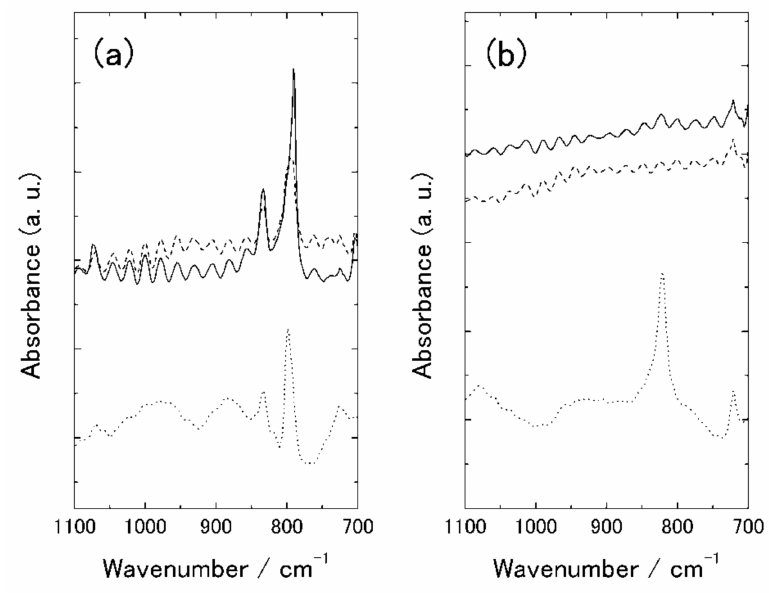
Figure 5. Polarized transmission IR spectra (upper) and IR-reflection absorption spectra (RAS) (lower) in the C–H deformation region of the friction-transferred PT film ( a ) and those of the friction- transferred P3DDT film ( b ). The polarization direction in transmission spectra is parallel (solid line) and perpendicular (dashed line) to the drawing